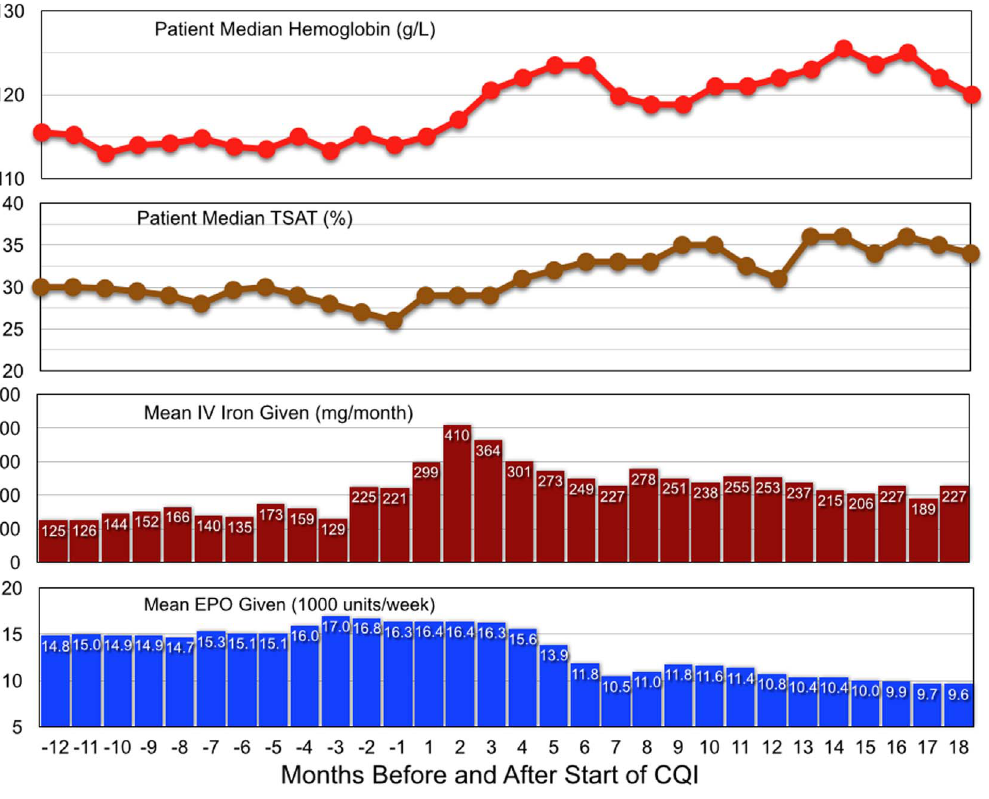
Figure 4. For all study patients, patient median Hb, median TSAT, mean IV iron and mean EPO administered in the protocol period 12 months before study start and the 18-month CQI